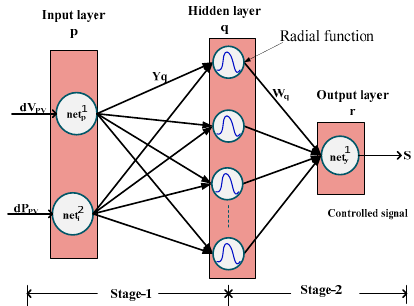
Figure 8. The architecture of a RBFA-based NN MPPT controller. Table 1. Working behavior of the fixed step size radial basis functional algorithm (RBFA) based MPPT technique.